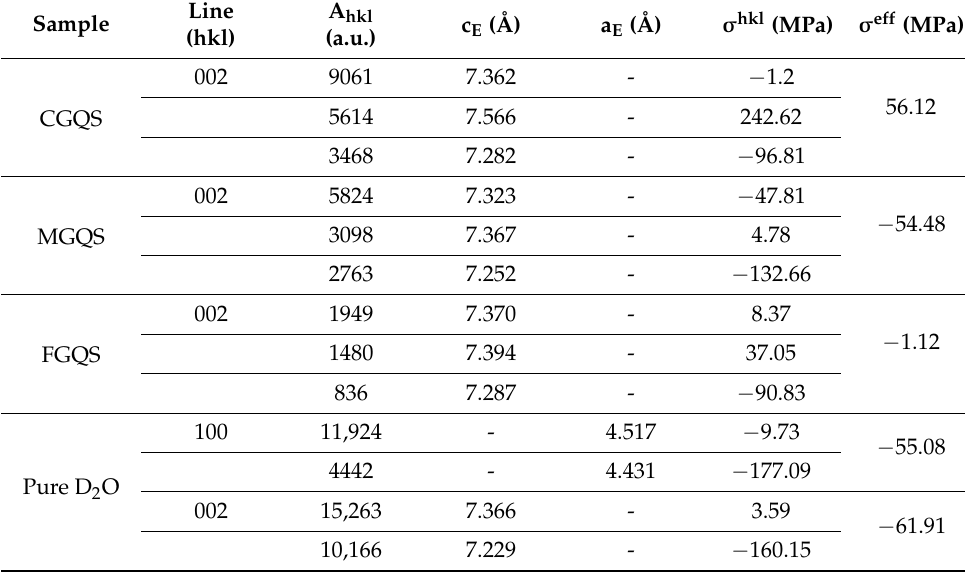
Table 1. Lattice parameters (c E , a E ) and radial stress values ( σ 100 , σ 002 , σ eff ) calculated from the observed split diffraction lines (with Miller indices hkl and integral intensity A hkl ) for the studied sample types; T = 250 K; the positive/negative stress value corresponds to a tensile/compressive stress,